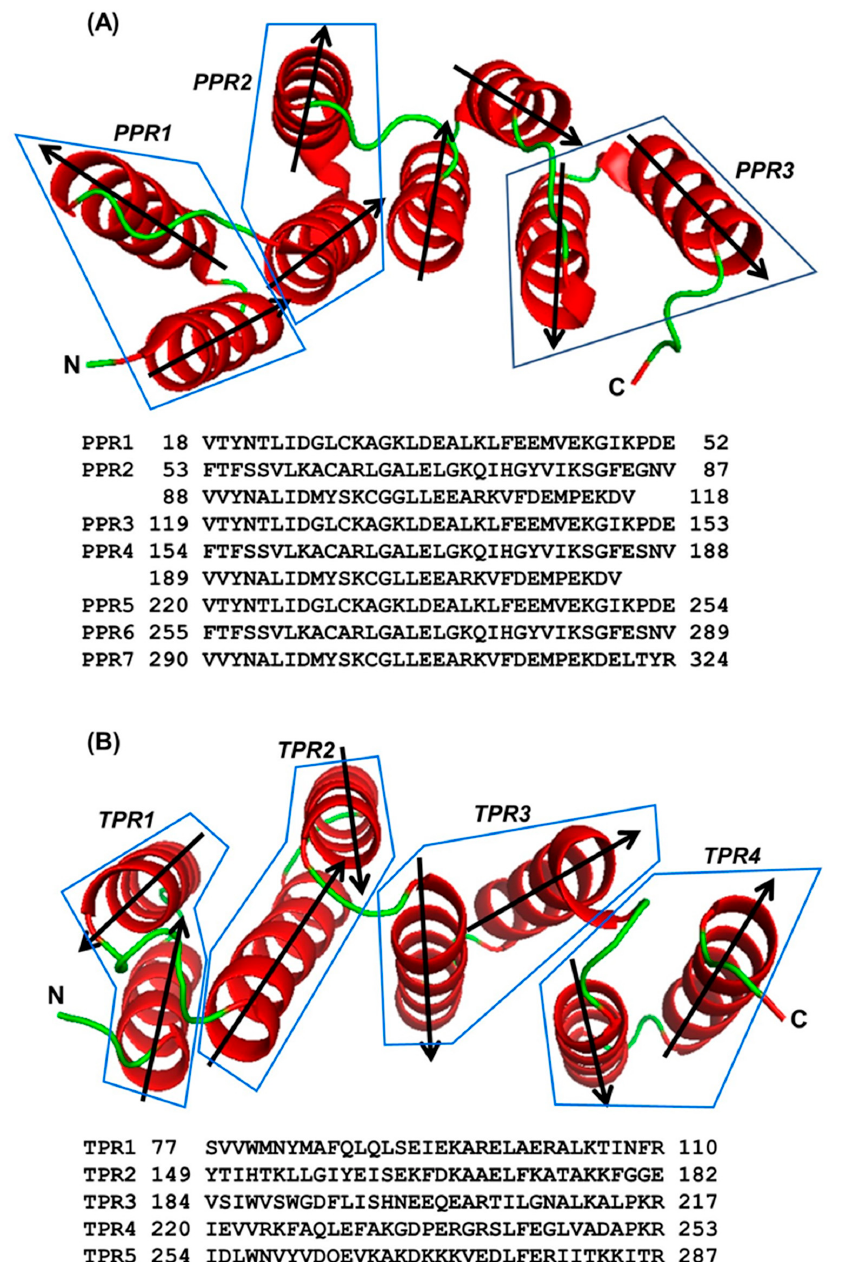
Figure 5. Superhelical structure of a multi-PPR domain. The superhelical structure of a PPR domain is shown along with that of a TPR domain to illustrate the similarities. ( A ) PPR domain of the plant ‘multiple organellar RNA editing factor’ (MORF, also known as ‘RNA editing factor interacting protein’ or RIP) from PDB 5IWW, Chain D [41]. The first three PPRs (out of a total of seven) are shown as representative, and demarcated by polygons. The two unboxed helices belong to a non-PPR sequence between the second and third PPR. ( B ) TPR domain (for comparison) of RRP5, an essential factor for ribosome maturation in yeast; PDB WWM, Chain B [24]. Only four TPRs of the multi-TPR C-terminal region are shown and each is demarcated by a polygon. In both panels A and B, the helices are dark red in color and the connecting linkers are green. The two termini of the peptide (amino, N and carboxy, C) are labeled, and the directionality of each helix is also indicated by arrowheads, which shows their antiparallel